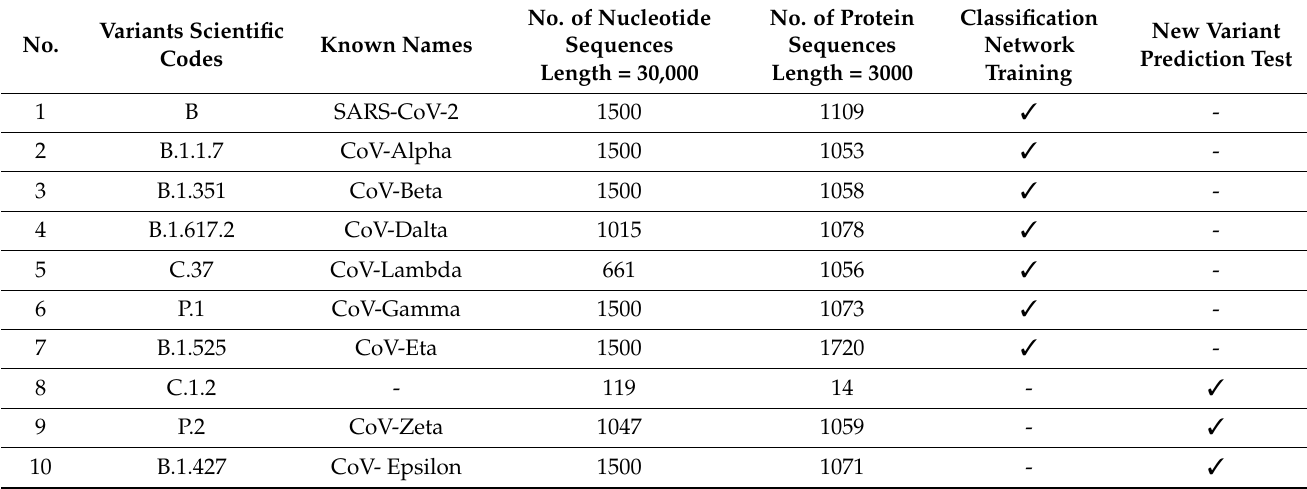
Table 1. Data collected from NCBI for the classification and new variant prediction tasks.